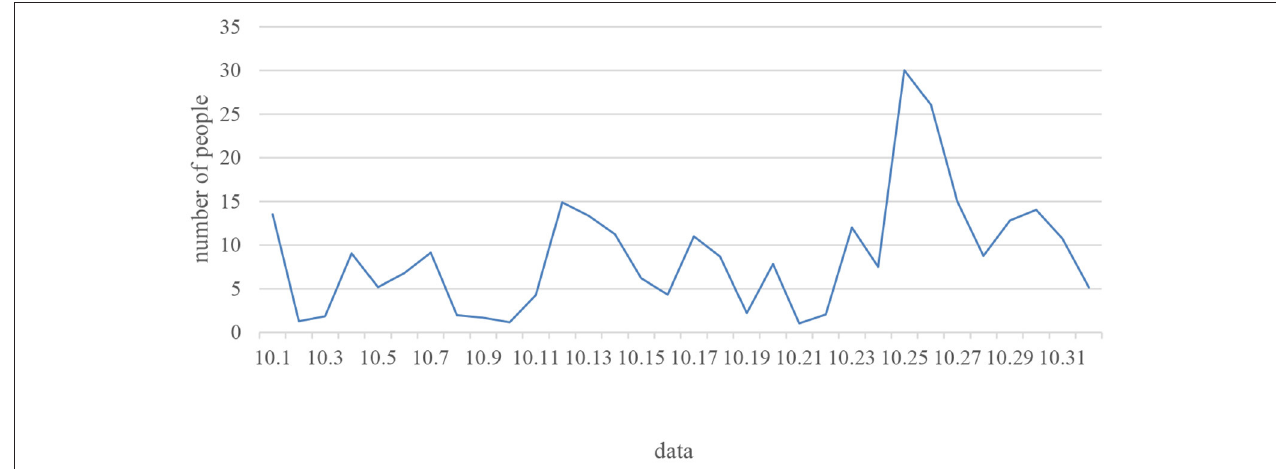
FIGURE 6 | Number of visits to the student course page.